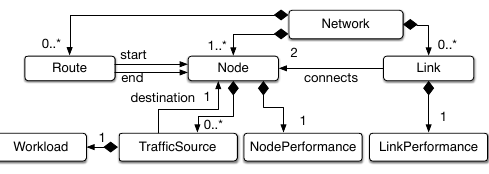
Figure 2: miniDNI meta-model